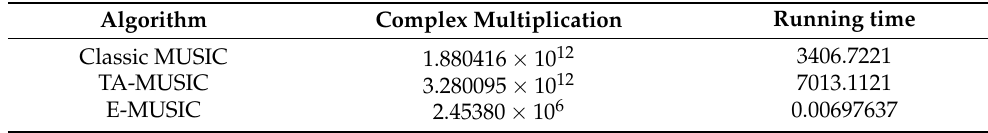
Table 1. Computational complexity of different